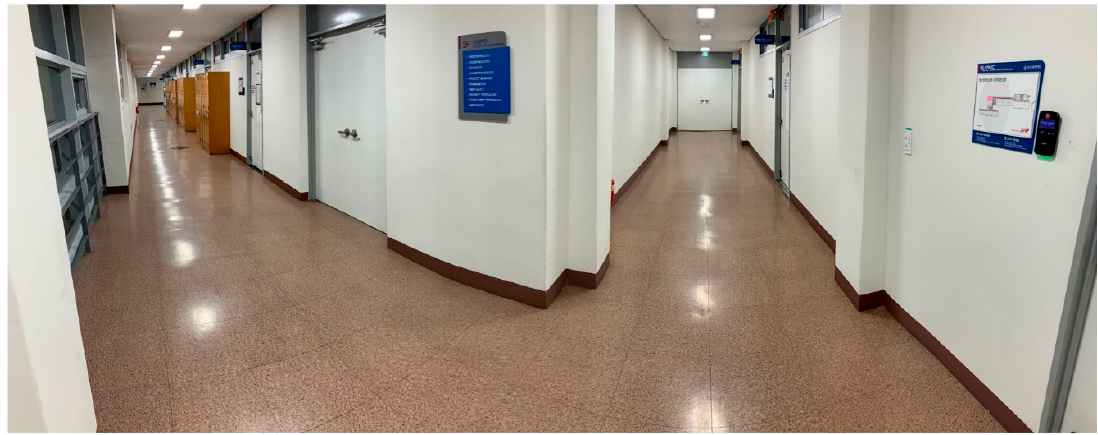
Figure 14. Indoor space (corridor) wherein first autonomous scanning experiment was performed (panoramic view) (panoramic (panoramic view)